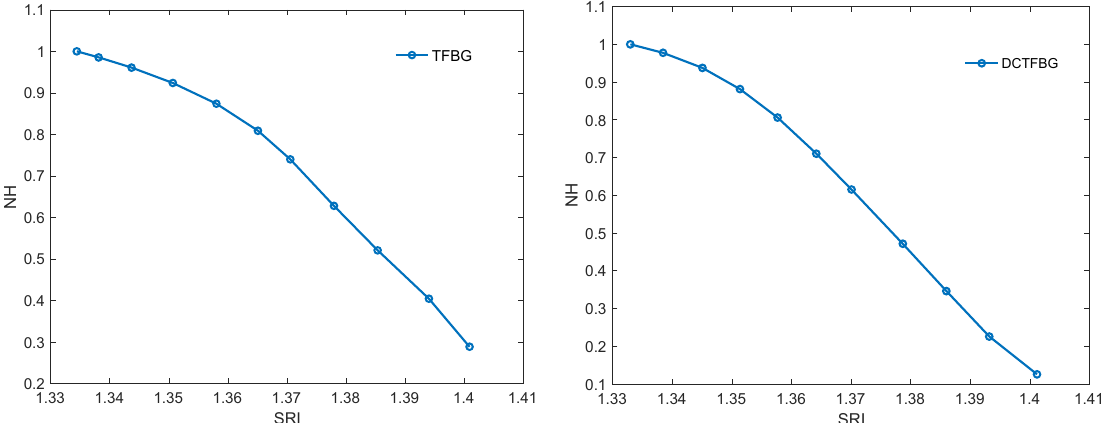
Figure 14. Change of normalised Hilbert envelope from SRI for TFBG (band 1) and DCTFBG (band 2). Table 2. Comparison of the resolution for the Hilbert envelope method for the TFBG and DC-TFBG for the optical spectra for individual frequency ranges.